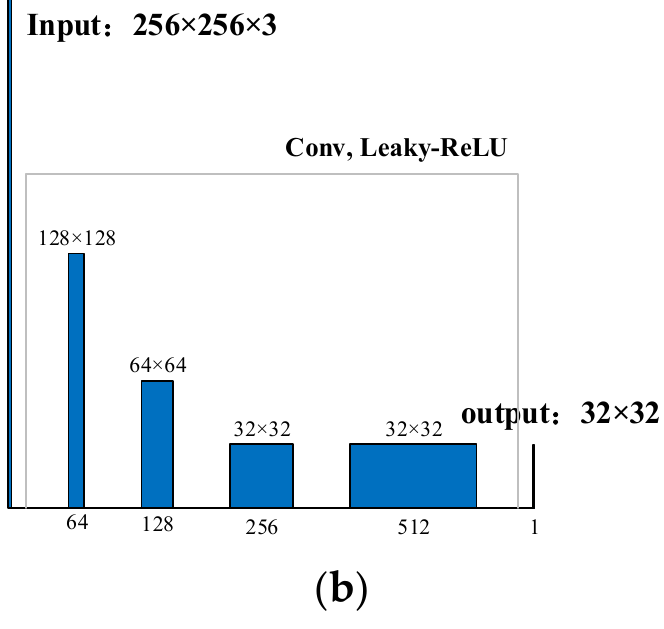
Figure 4. The architectures of generative network ( a ) and discriminative network ( b ). In the discriminative network, PatchGAN is selected as the network architecture. As a Markovian discriminator, PatchGAN was proven to be a better discriminator than regular GAN for the purpose of image processing, especially in terms of image resolution and image details. The main difference is that regular GAN discriminator outputs a scalar that represents the input image is real or fake, while for PatchGAN, its discriminator outputs a matrix in which each element represents a patch (receptive field) in the input image that is real or fake. In the study, the size of the output of the discriminator is 32 × 32. Each convolution layer consists of 4 × 4 filtering with stride 2 along with Leaky-ReLU activation. The architecture of discriminator in the GAN is depicted as Figure 4b. The width and height of the boxes represent the width and height of the feature map, and different boxes correspond to different convolutional layers of the network. The loss functions used to train the discriminator and generator are selected as Wasser- stein GAN (WGAN) function and L1-norm, respectively. To improve the stability of training, a penalty term is added to the WGAN. Based on (8), the overall loss function in the